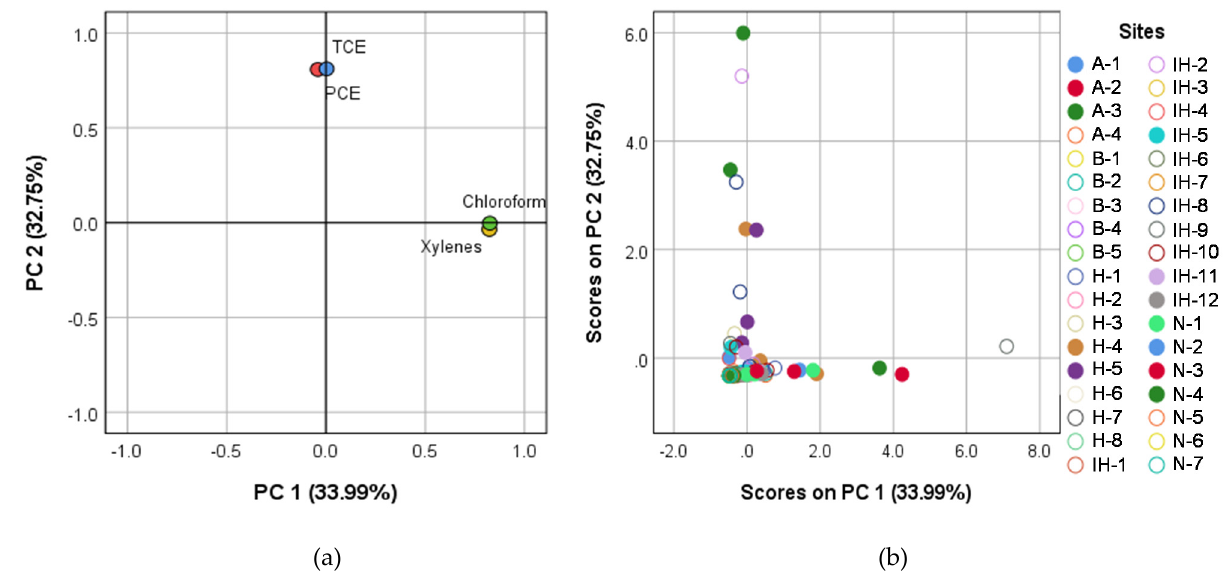
Figure 4. ( a ) Loading plot and ( b ) scores plot of the PCA. Xylenes include m-, o-, and p- isomers of xylene; N: Namhan River; B: Bukhan River; IH: Imjin-Hantan River; H: Han River mainstream; A: Anseong Stream.